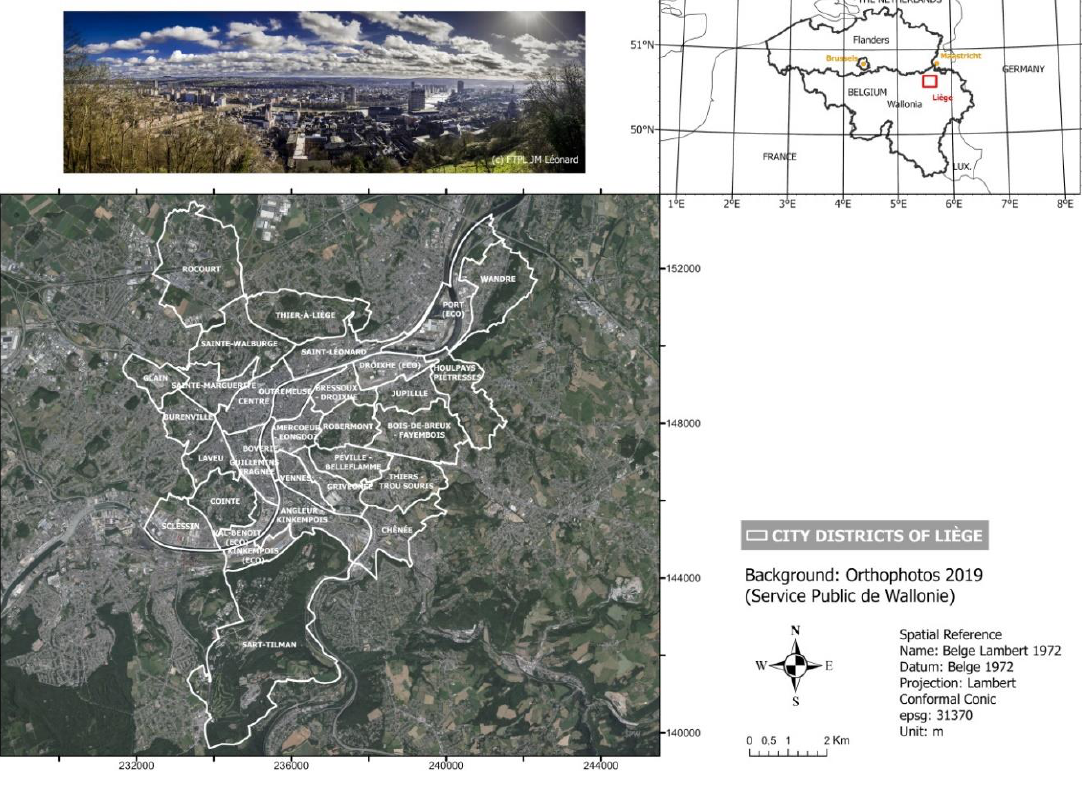
Figure 2. Location of the city of Liège, Belgium, and of its 32 districts. (Top-left) Illustration of the topography and land cover of Liège with its dense urban centre along the Meuse River and its vegetated